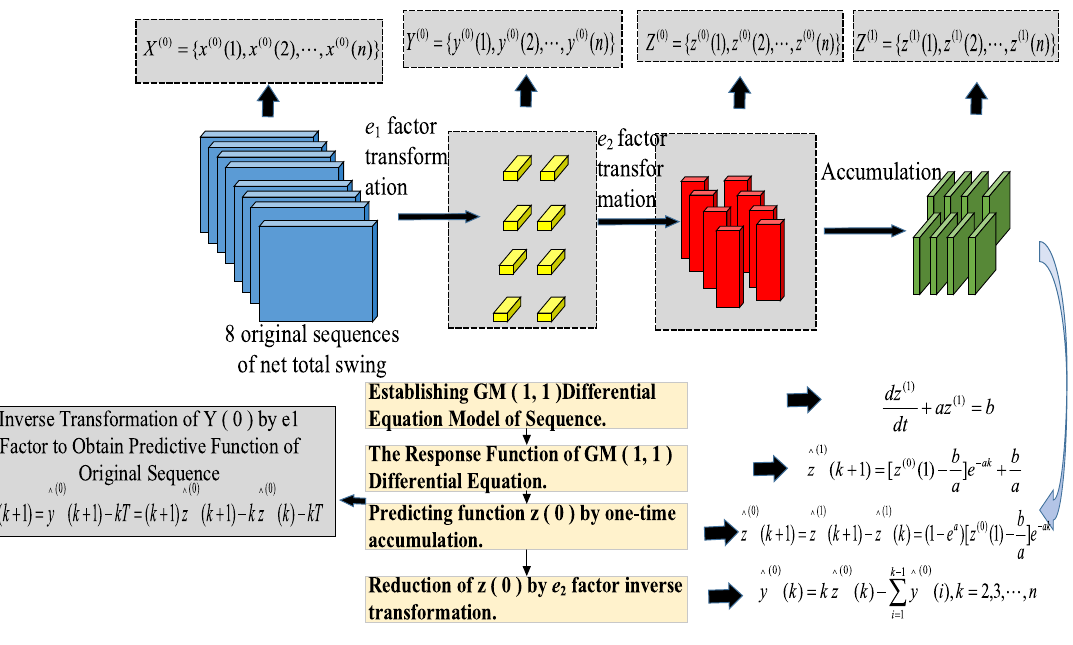
Figure 2. Framework diagram of the improved GM algorithm.